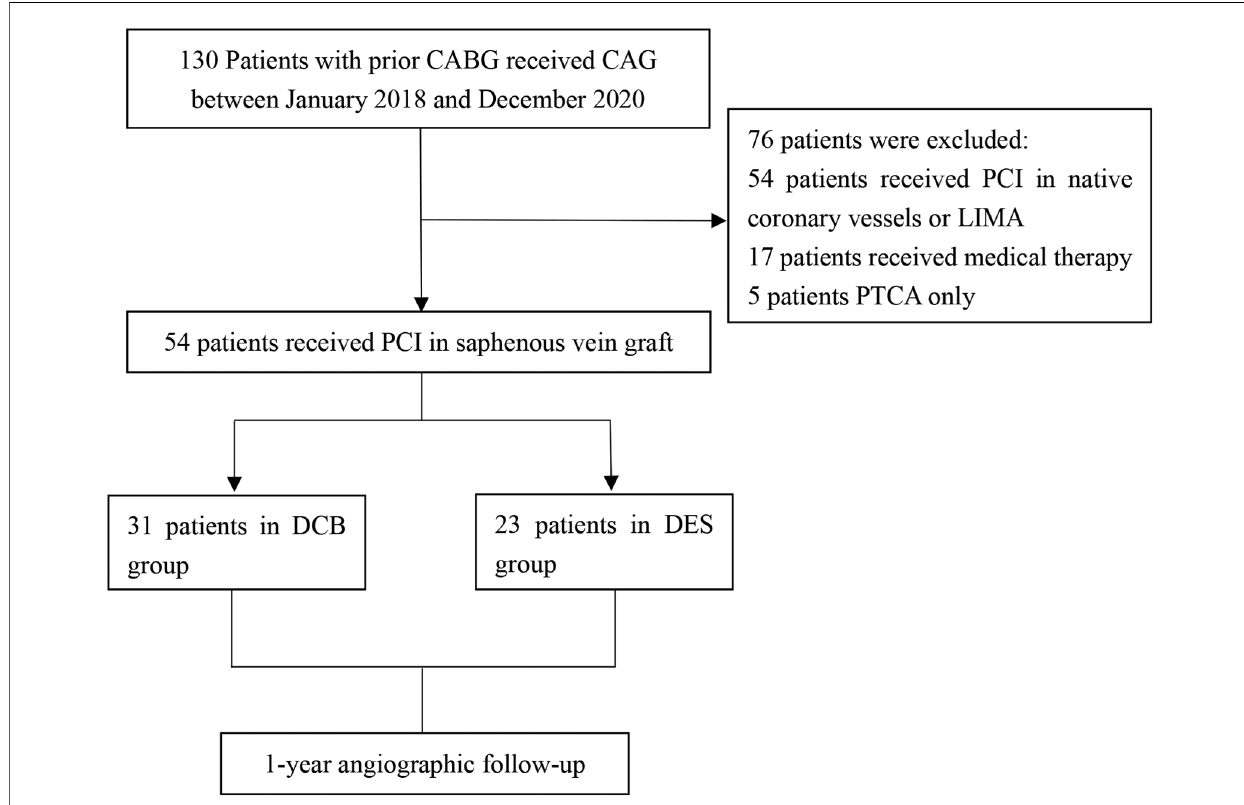
FIGURE 1 Study population. CAG, coronary angiography; PCI, percutaneous coronary intervention; DCB, drug-coated balloon; DES, drug-eluting stent; CABG, coronary artery bypass grafting; PTCA, percutaneous transluminal coronary angioplasty; LIMA, left internal mammary